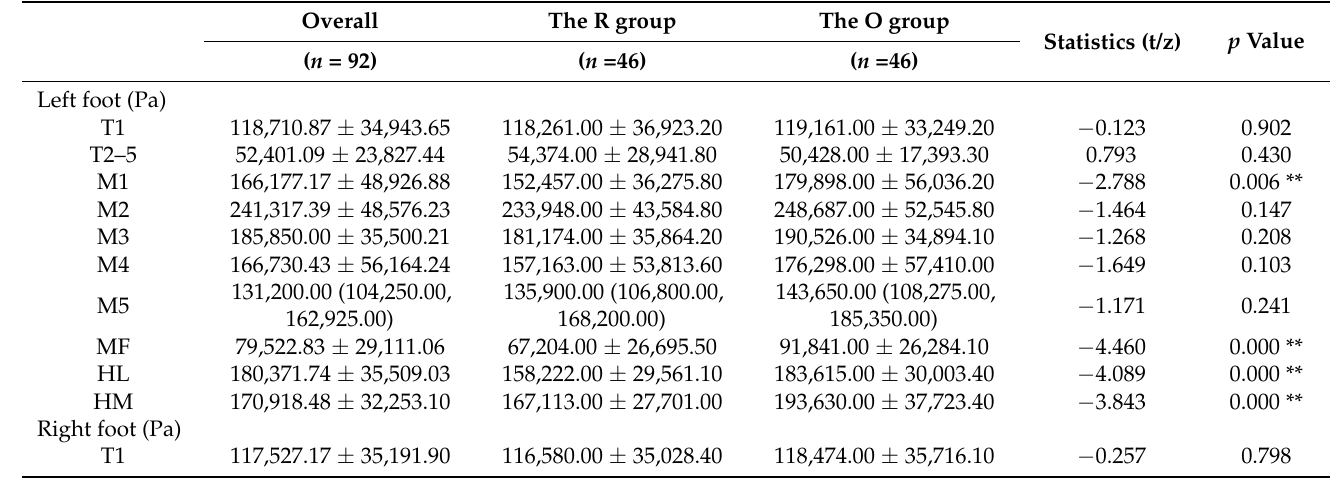
Table 8. Peak pressure of the older women in the O and R